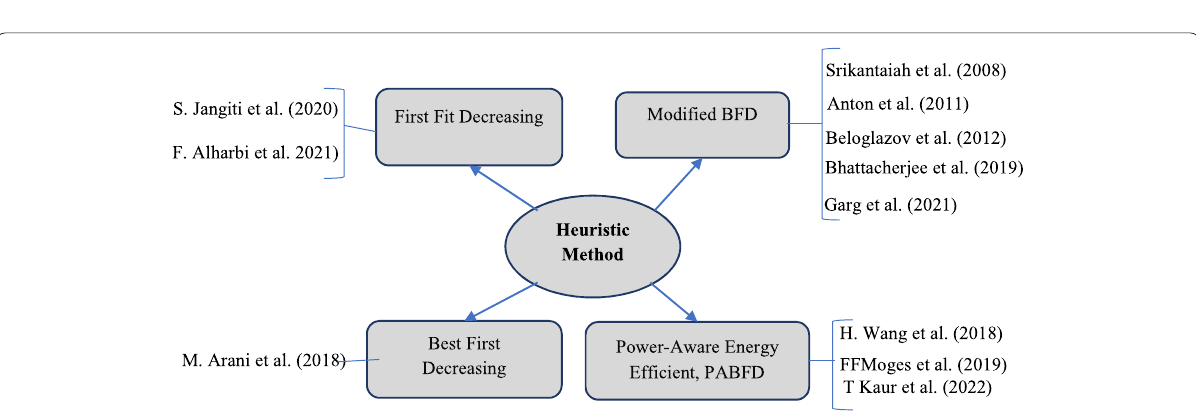
Fig. 4 Stages of Dynamic VM Consolidation